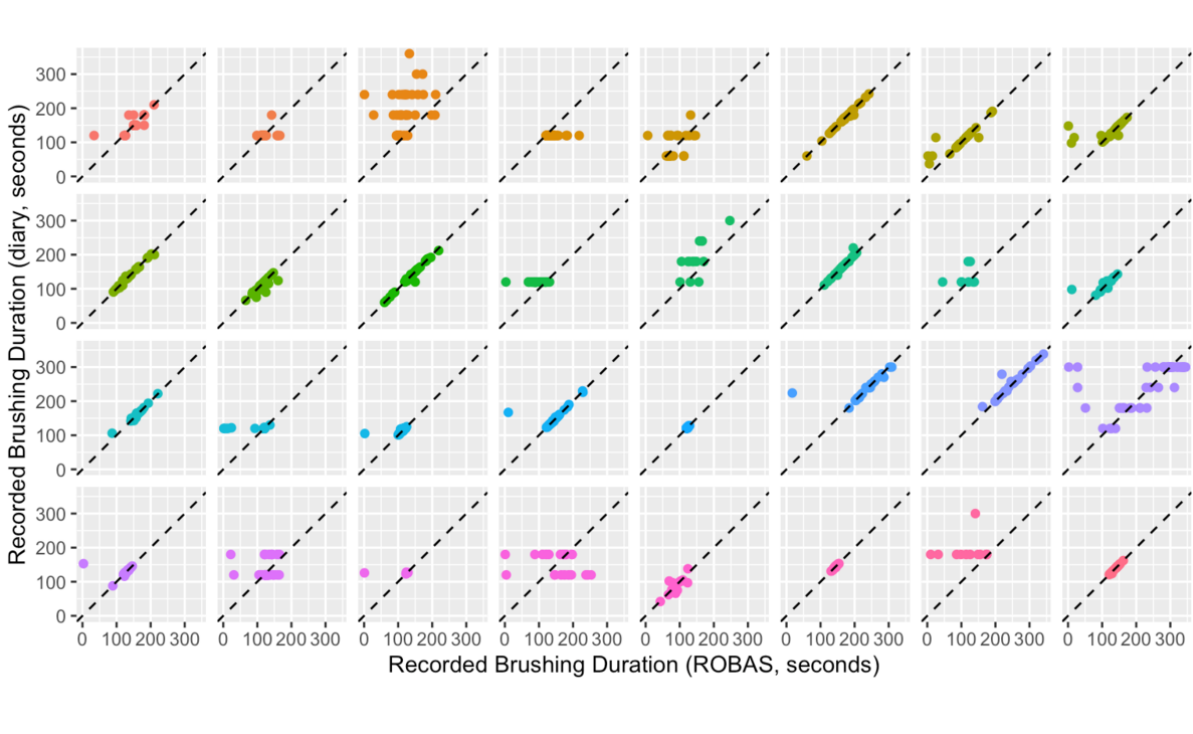
Figure 6. Durations of individual brushing sessions, as measured by ROBAS and brushing diaries, grouped by participant. Horizontal alignment of some data points suggests guessed approximations. ROBAS: Remote Oral Behaviors Assessment